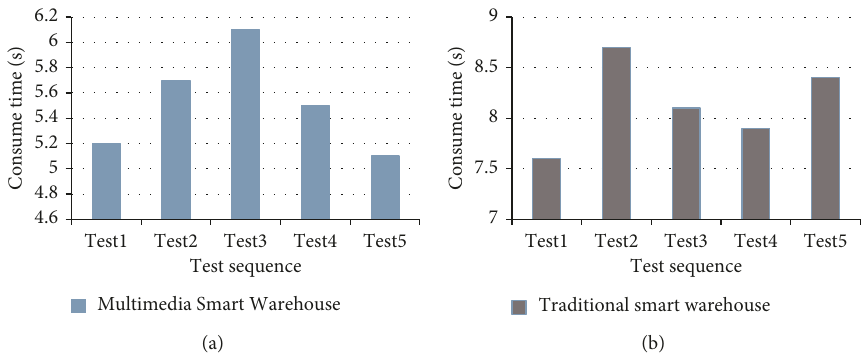
Figure 9: Intelligent warehousing troubleshooting time. (a) shows the time spent on troubleshooting the intelligent storage system based on multimedia technology. (b) shows the time taken to troubleshoot the traditional intelligent storage system.